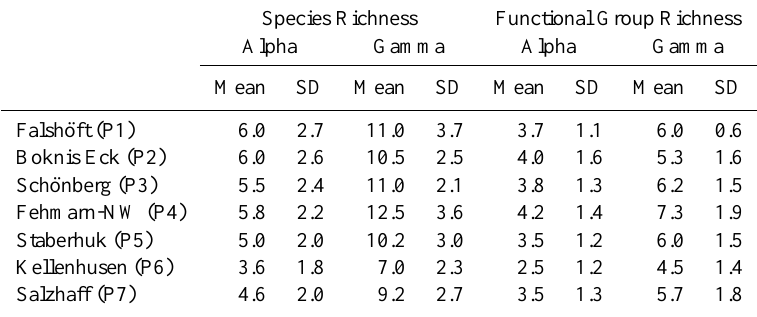
Table 3. Taxonomic and functional richness at the 7 stations: alpha richness is the mean number of taxa or functional groups per panel, gamma richness is the total number of taxa or functional groups found on all panels of a given station (averaged over the years). SD: standard